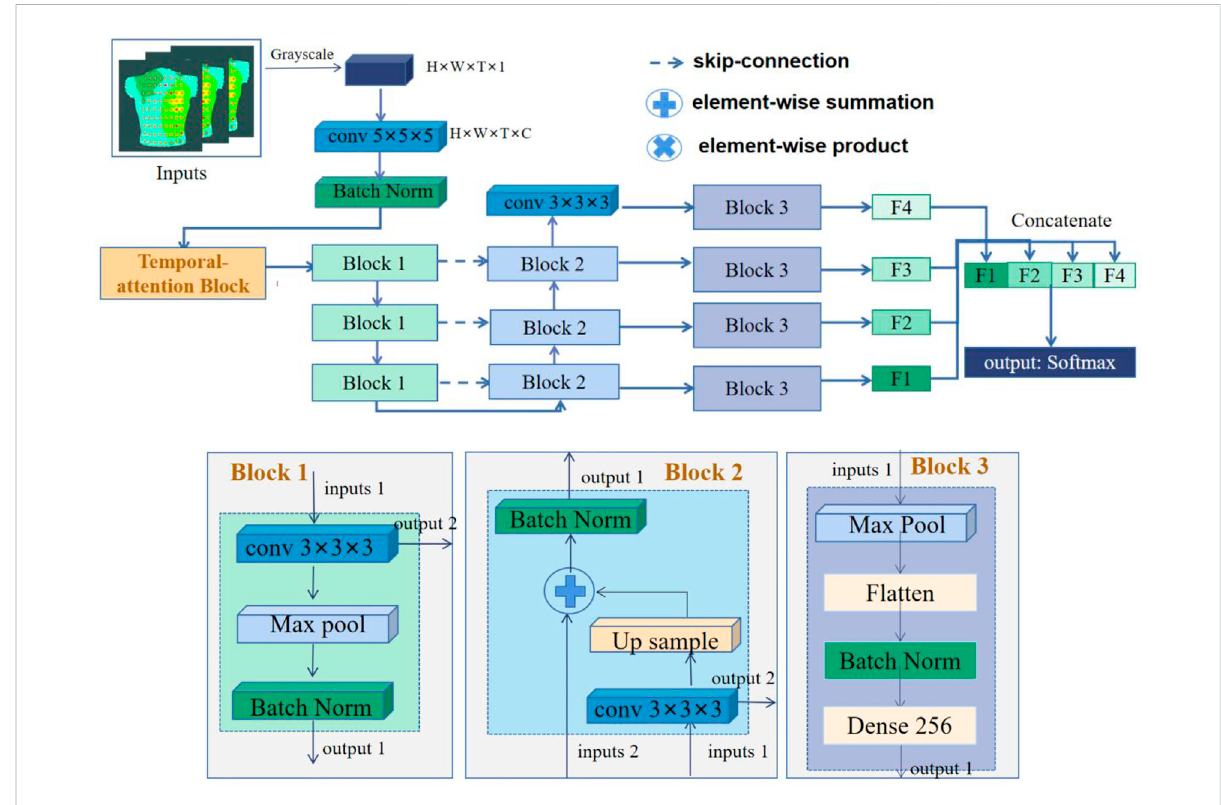
FIGURE 2 Structure diagram of the 3D-CNN classi fi cation